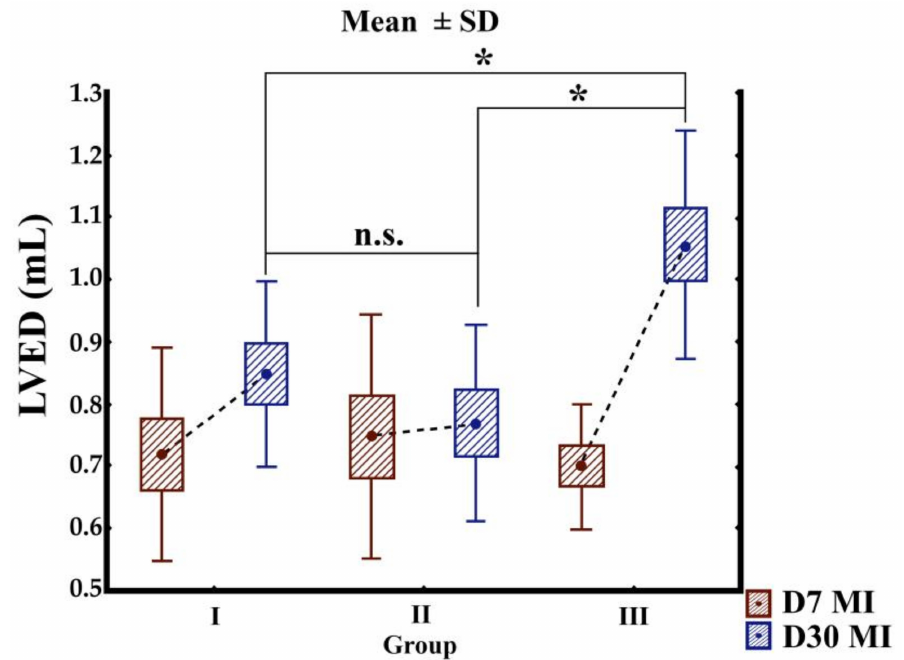
Figure 5. Graphs show echocardiographic measurements of left ventricular end-diastolic